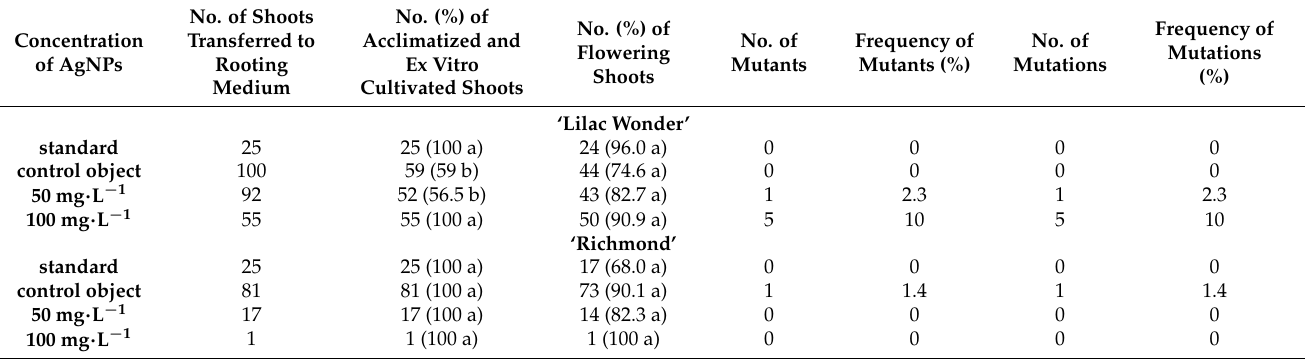
Table 2. Rooting, acclimatization, and flowering of Chrysanthemum × grandiflorum ‘Lilac Wonder’ and ‘Richmond’ shoots, depending on the AgNPs treatment (0–100 mg · L − 1 ).